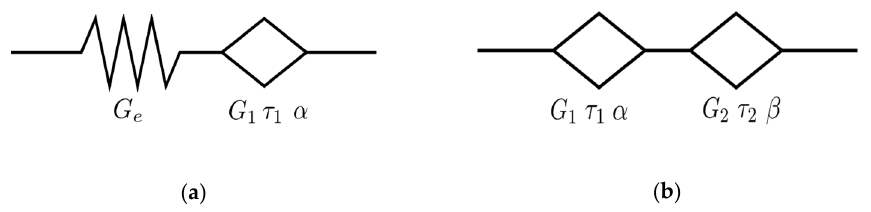
Figure 2. Maxwell fractional model with ( a ) one spring-pot; ( b ) two spring-pots.